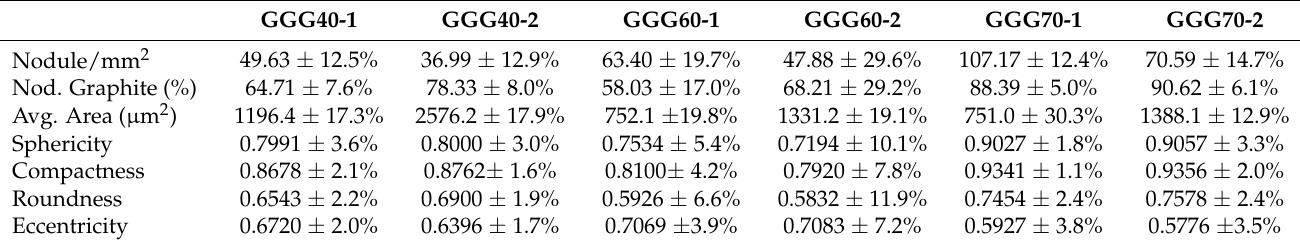
Table 4. Round bar specimens graphite